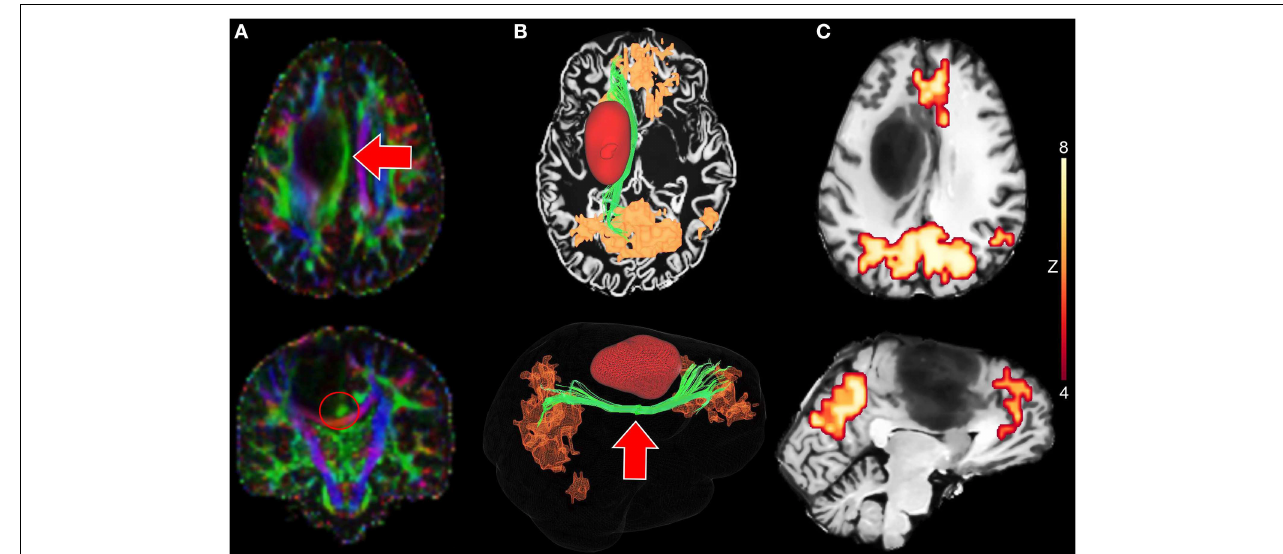
FIGURE 6 | Tractography-driven reconstruction of the DMN applied to a neurosurgical case. (A) Axial and coronal views of RGB map showing the deviated Cg (red arrows) induced by the mass effect of the tumor. (B) 3D reconstruction of the Cg (green), the tumor (red) and the DMN (orange)